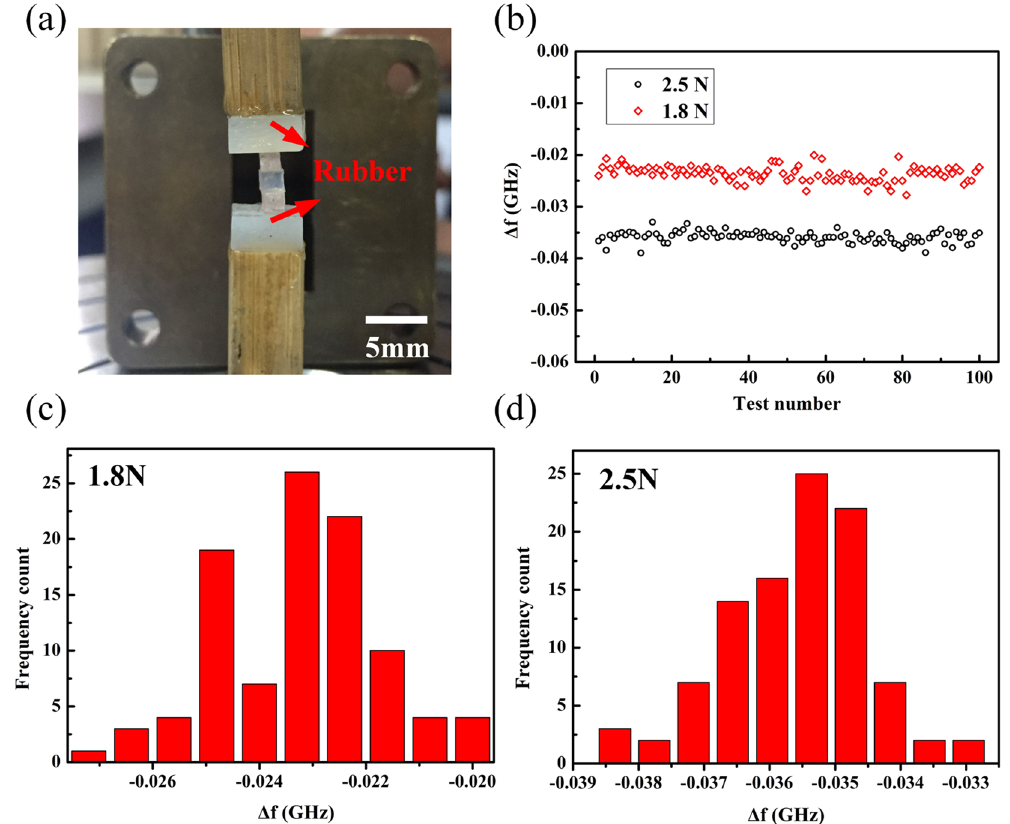
Figure 5. ( a ) Measurement setup for testing of the stability of the sample between soft materials. ( b ) Measured values of the frequency shift of the sensor for 100 repeated tests at loading levels of 1.8 N and 2.5 N. ( c ) Statistical distribution for the 100 repeated tests under a loading force of 1.8 N. ( d ) Statistical distribution for the 100 repeated tests under a loading force of 2.5